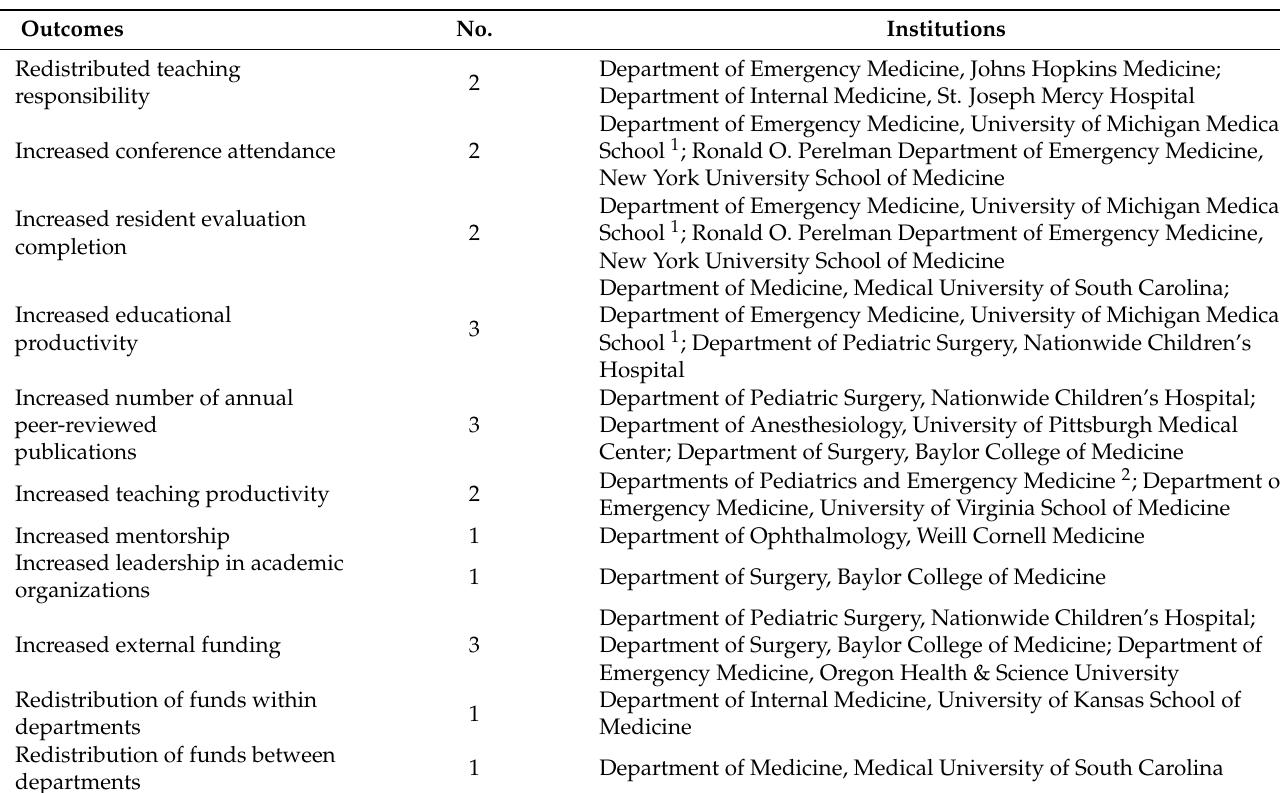
Table 2. Outcomes Associated with the Implementation of an EVU System in Reporting U.S. Medical